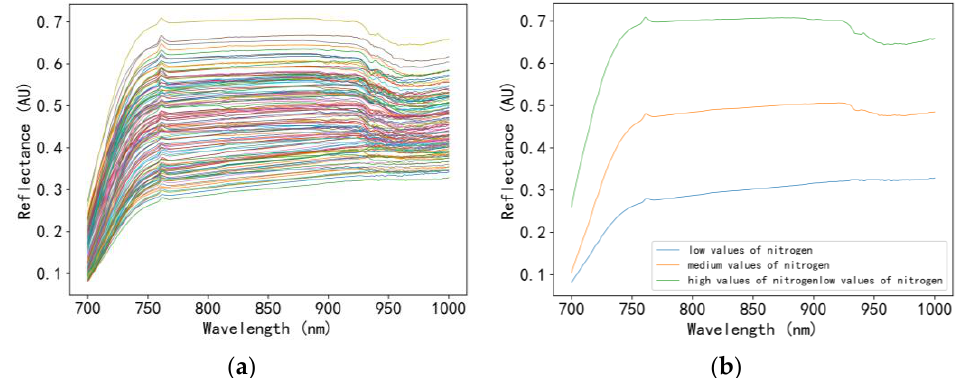
Figure 7. Spectral curve: ( a ) original spectral curve of the tea tree leaf samples; ( b ) mean reflectance curves for high, medium, and low values of nitrogen.